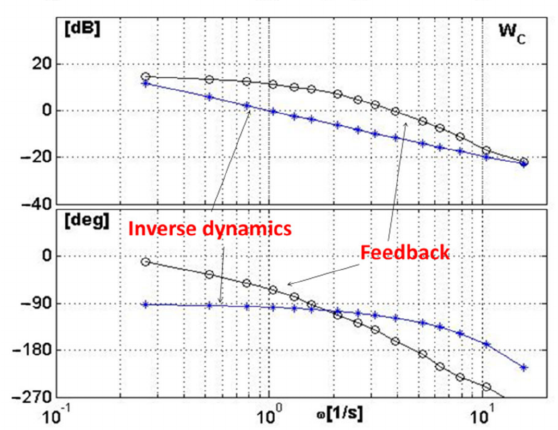
Figure 2. Inverse dynamics vs.